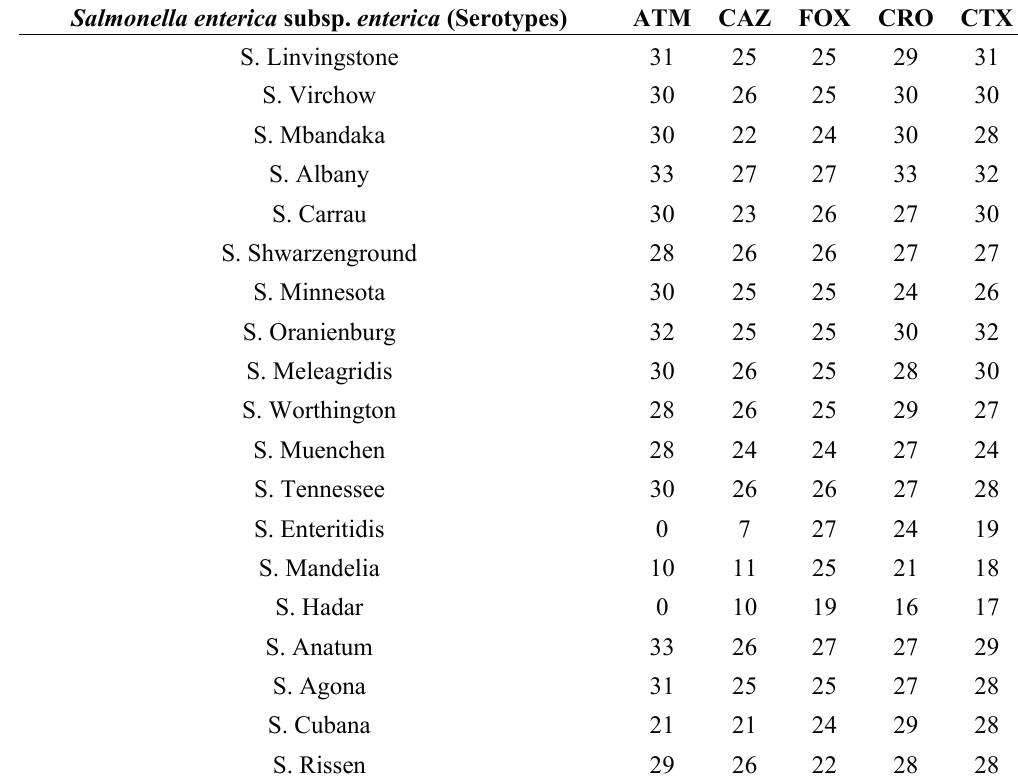
Table 1. Average inhibition zone diameters (mm) for the tested antibiotics for each of the Salmonella serotypes in three analysis.